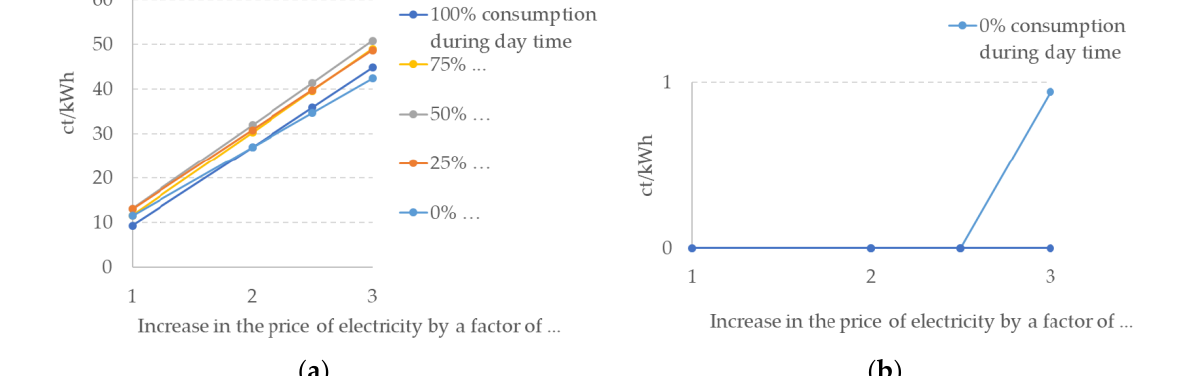
Figure 13. ( a ) Economic advantages of investing in PV and wind systems for operational power supply and ( b ) additional benefits of investing in batteries.